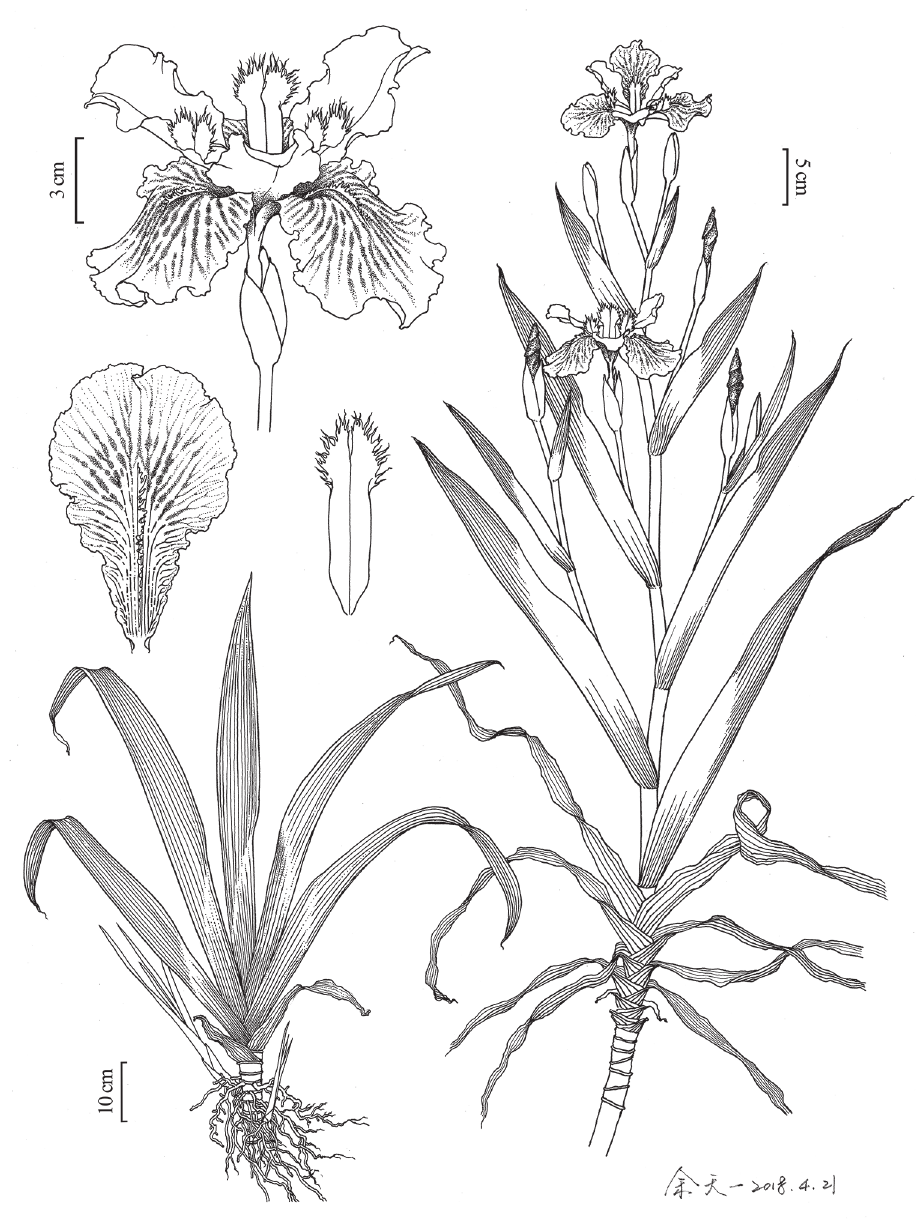
Figure 1. Line drawings of Iris × ampliflora based on photos and the type specimens (Drawn by Tian-Yi